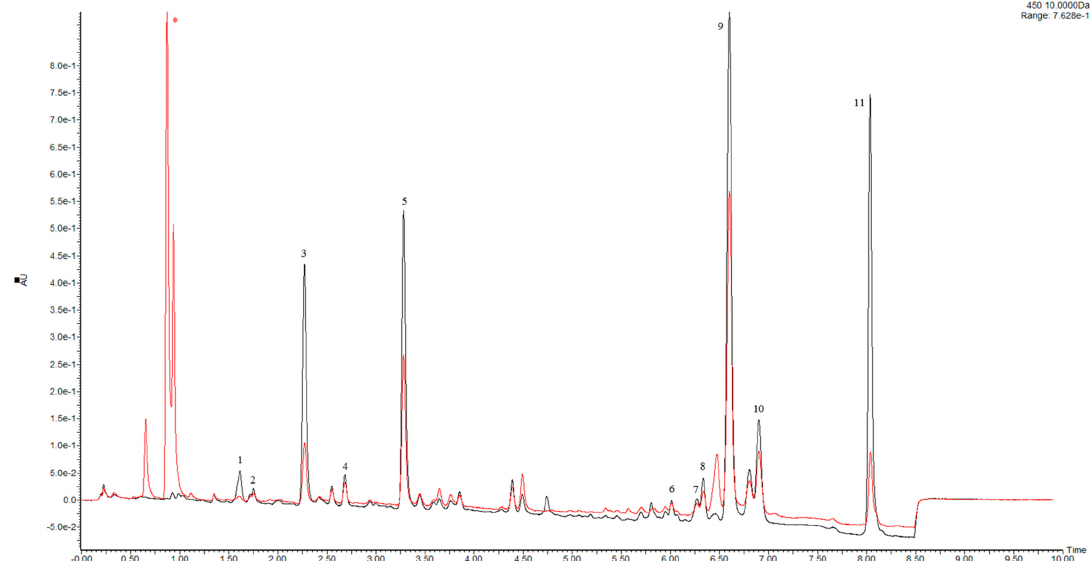
Figure 3. UV/Vis-UHPLC- (450 nm) chromatograms of Spirulina pigment extract before (black) and after (red) reaction with DPPH radical (marked with an asterisk).